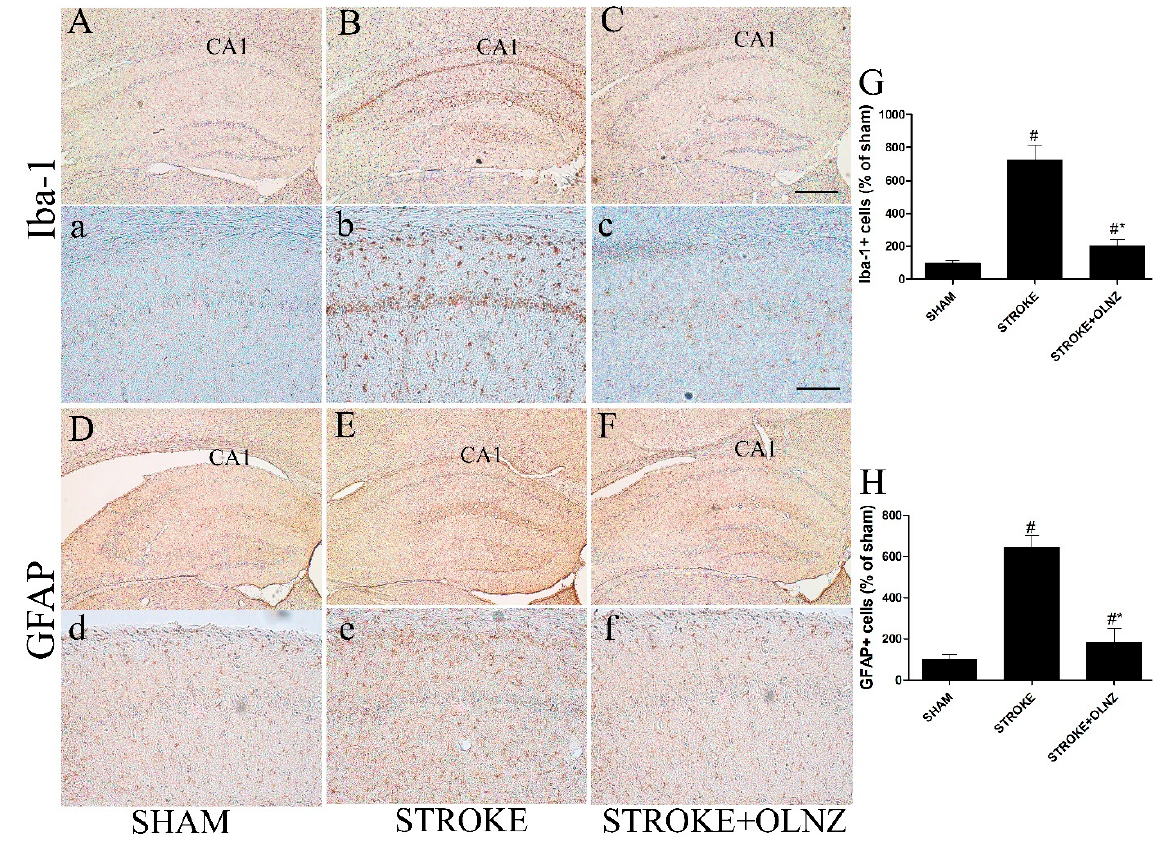
Figure 4. Role of OLNZ in Iba-1-immunoreactive microglia and GFAP-immunoreactive astrocyte cells in the CA1 area of the hippocampus. Identification of Iba-1+ neuronal cells in the sham ( A ) 10× and ( a ) 200x, TI-mediated ischemic stroke ( B ) 10× and ( b ) 200×, and TI- mediated ischemic stroke +OLNZ (10mg/kg) ( C ) 10× and ( c ) 200× groups and of GFAP immunoreactive astrocytes in the CA1 region in the sham ( D ) 10× and ( d ) 200×, TI- mediated ischemic stroke ( E ) 10× and ( e ) 200×, and TI- mediated ischemic stroke +OLNZ (10mg/kg) ( F ) 10× and ( f ) 200× groups. In the TI- mediated stroke group, Iba-1+ cells were notably augmented and GFAP+ cells exhibited bigger and denser processes in the CA1 area compared with OLNZ treatment groups. ( G ) Graphs signify the relative numbers of Iba1+ and ( H ) GFAP immunoreactive cells. Data were expressed as the mean ± SEM, n = 5 in each group. After performing a one-way ANOVA with Tukey’s post hoc test, p < 0.05 for comparisons of treatment groups with the sham group (#) and p < 0.05 for comparisons with the TI-induced stroke group (*) were considered significant.